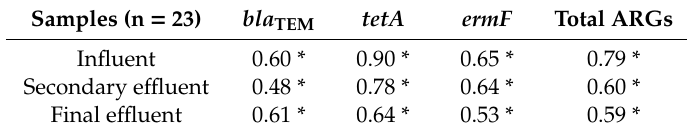
Table 3. Kendall tau ( τ ) correlation coe ffi cient between intI1 and